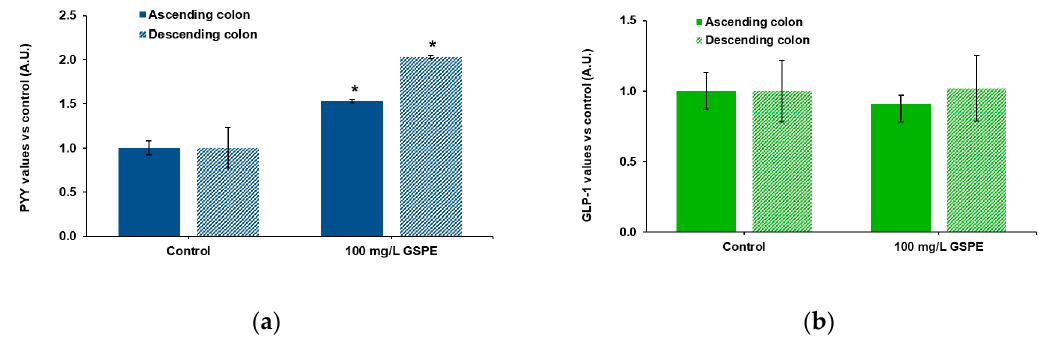
Figure 3. Enterohomone secretion in the medium after stimulation of human ascending (dark columns) and descending (light columns) colon explants with grape seed proanthocyanidin extract (GSPE, 100 mg/L). ( a ) PYY values, ( b ) total GLP-1 values. Results are expressed in arbitrary units (A.U.), which are values normalized versus the control and represent mean ± SEM. * p < 0.05 vs. control, t -test. n = 13–15 explants from 4–10 humans.